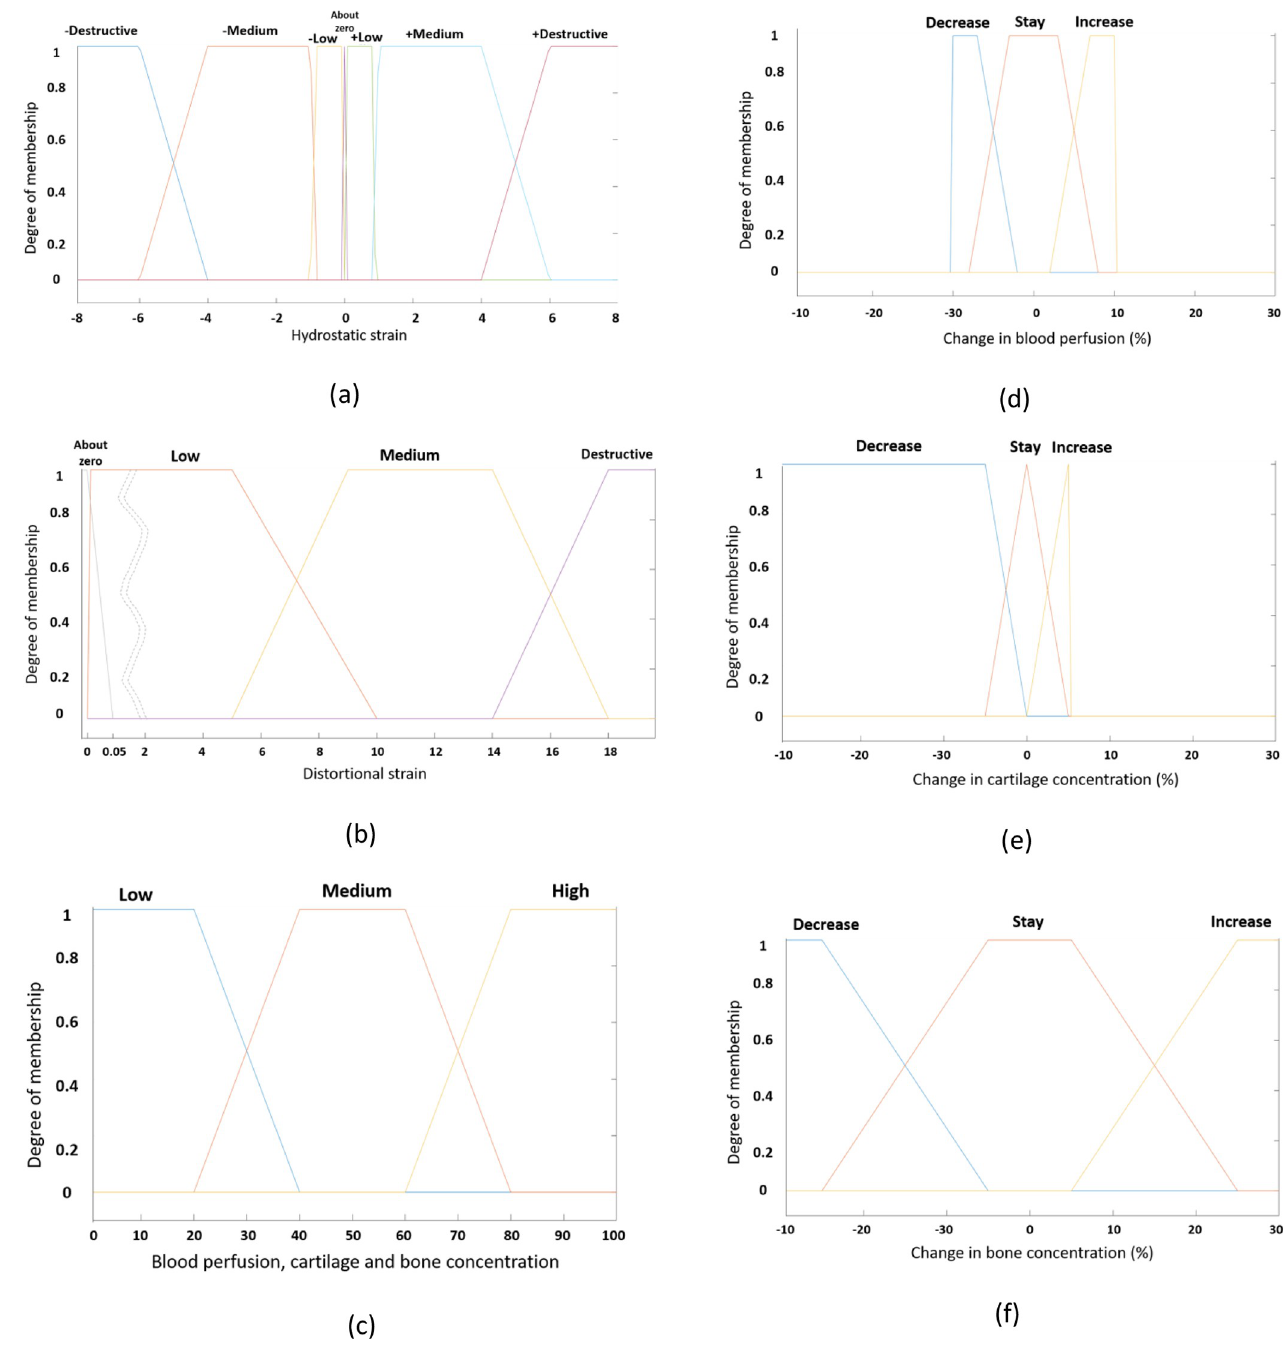
Fig 4. Membership functions: (a) and (b) were used to describe the first two input variables, e.g. hydrostatic strain and distortional strain, respectively, whereas (c) was used for the remaining five input variables, e.g. blood perfusion, perfusion in neighbour elements, cartilage concentration, bone concentration and bone concentration in neighbour elements. Membership functions (d), (e) and (f) were used to describe the three output variables, e.g. change in perfusion, change in cartilage concentration and change in bone concentration,